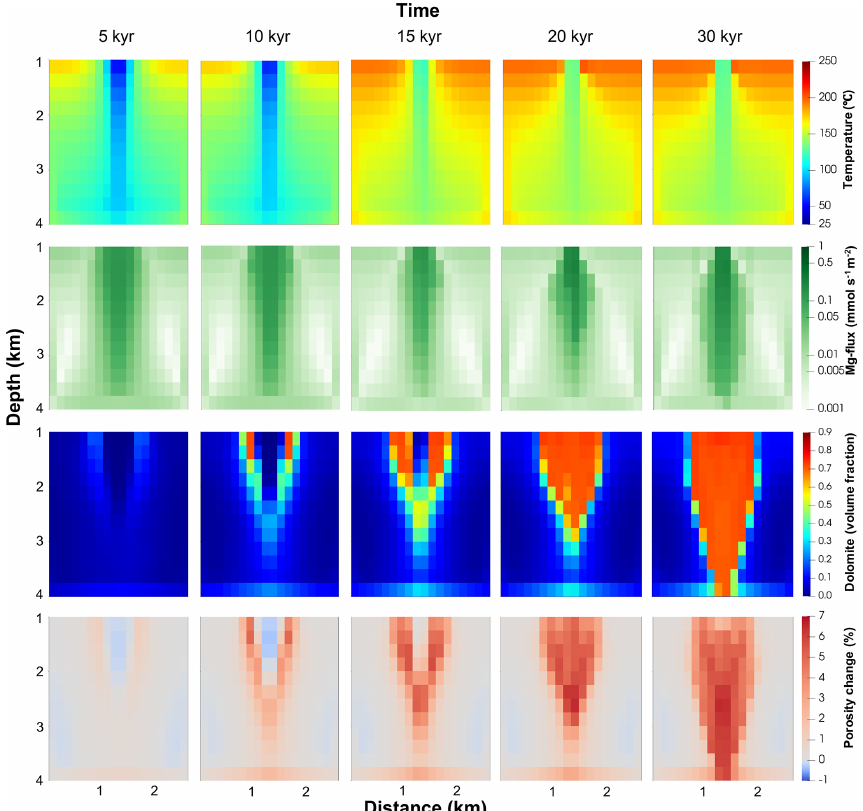
Figure 5. Temporal evolution of temperature, Mg 2 + -flux (fluid flux × Mg 2 + concentration), dolomite abundance (volume %), and change from initial porosity (volume %) along the fault plane for the 3D baseline simulation after 5, 10, 15, 20, and 30kyr. Two separate dolomite geobodies start to form in the FDZ in the upper part of the aquifer, with large areas where more than half the calcite has been replaced by dolomite. Over time, with dolomitisation, these merge to a single massive dolomite body with relatively sharp dolomitisation fronts. The downwelling core is initially a zone of minor calcite cementation, but the dominance of replacement dolomite over dolomite cementation results in an increase in porosity of up to